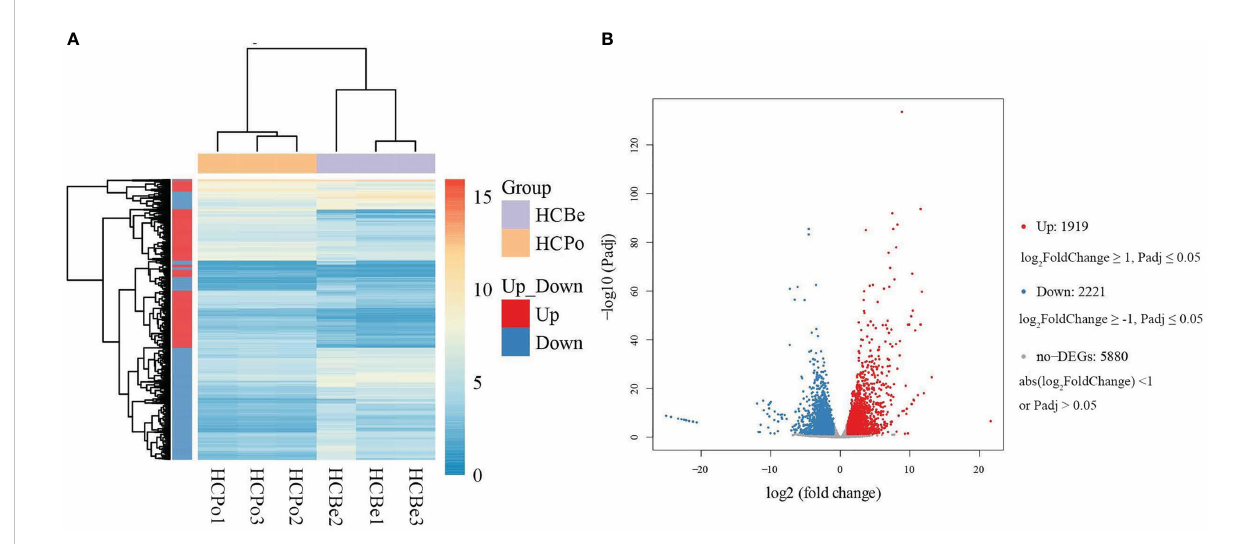
FIGURE 4 The differentially expressed genes of S. terricola from two types of media. (A) The heat map of expression levels of differentially expressed genes, (B) Volcano plot for HCBe vs. HCPo based on the DESeq2 method. “ Up ” and “ Down ” refer to levels in potato dextrose media as compared to bean media.